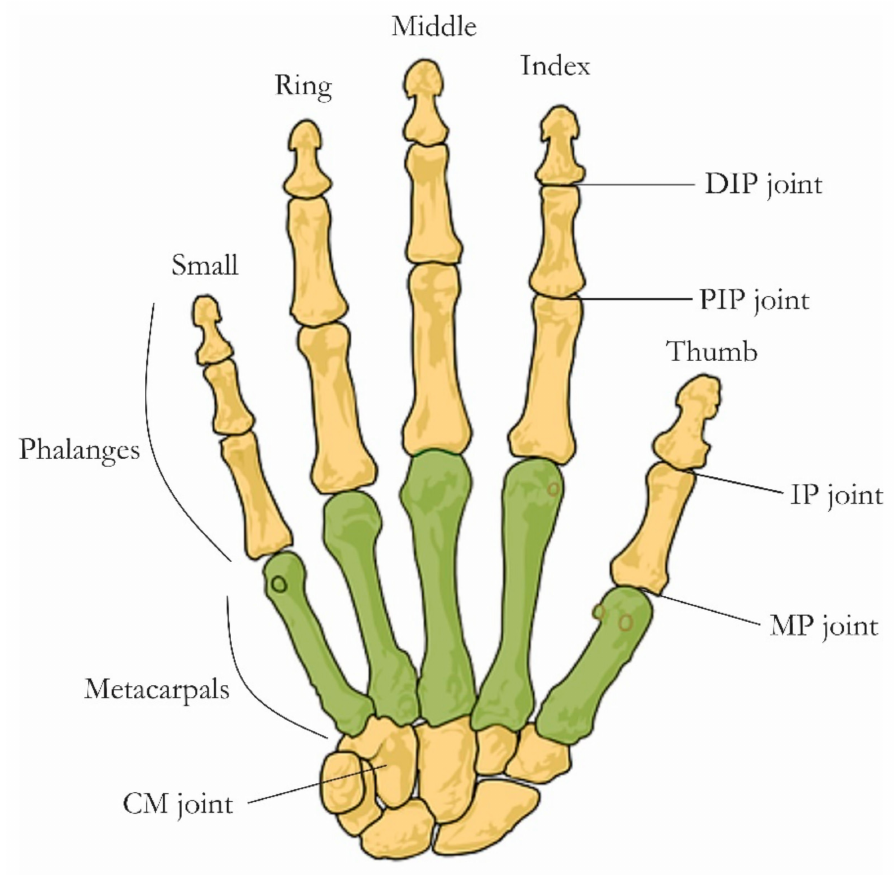
Figure 1. The terminology of bones and joints of the